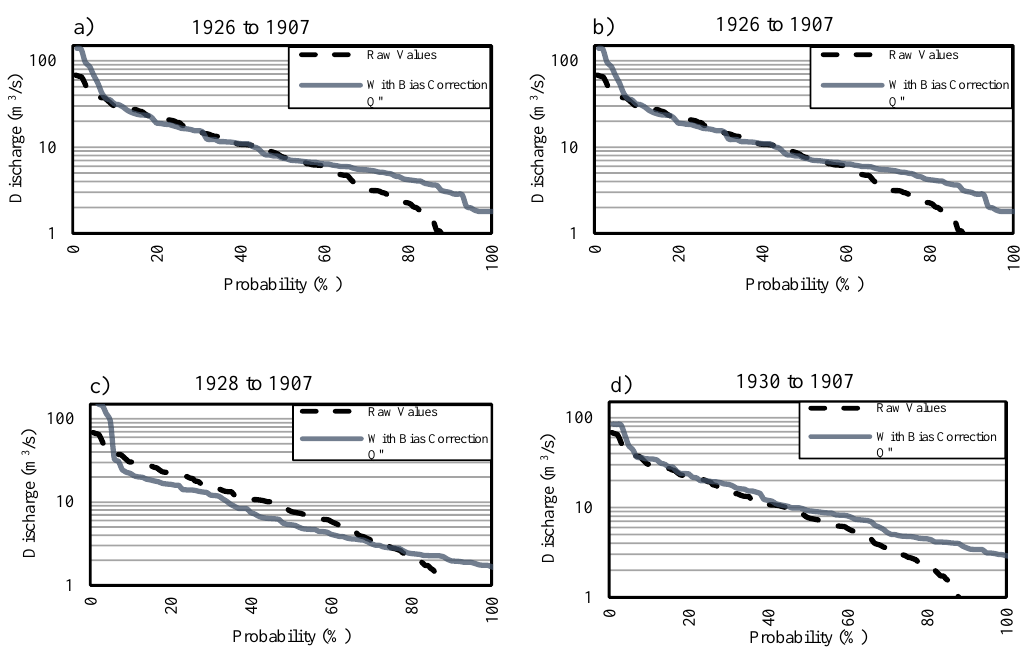
Figure 5. Flow duration curve for the number 1907 SGS. ( a ) 1926 to 1907, ( b )1927 to 1907, ( c ) 1928 to 1907, ( d ) 1930 to 1907